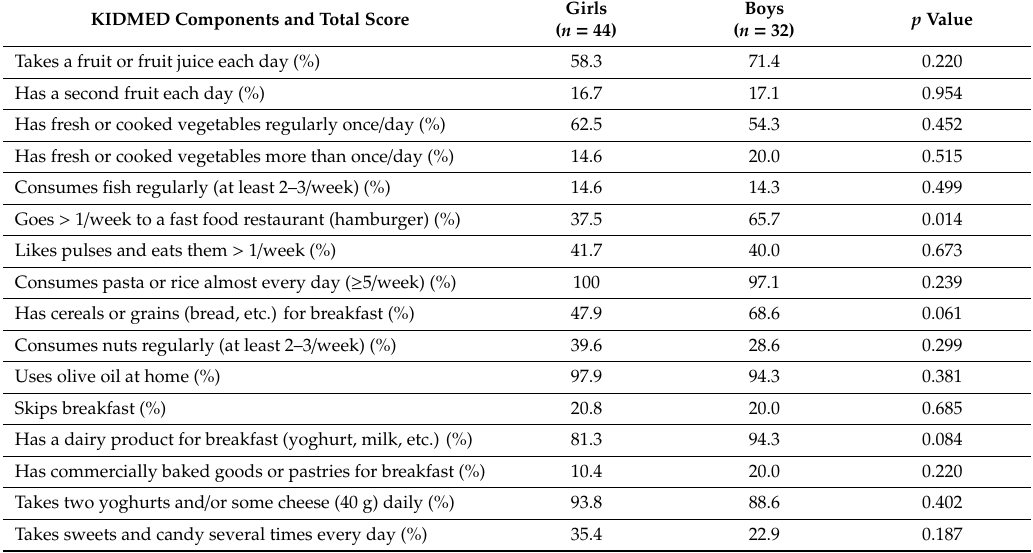
Table 3. Diet quality of children and adolescents with cystic fibrosis according to the KIDMED [24] score. KIDMED Components and Total